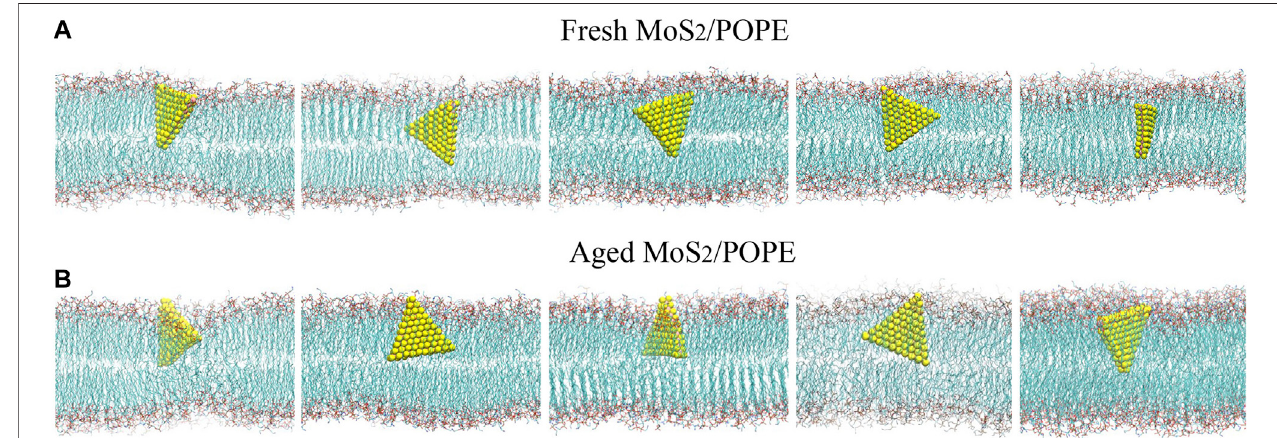
FIGURE2| MDsimulationsindicatedboththe (A) freshand (B) agedMoS 2 nanosheetscaninsertintothePOPE lipidmembrane. Finalconformations oftheMoS 2 nanosheets/lipid membrane from fi ve independent simulation runs are shown.